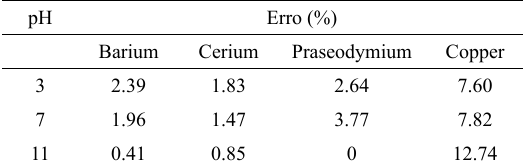
Table 4. Experimental errors (%) related to the chemical composition acquired by